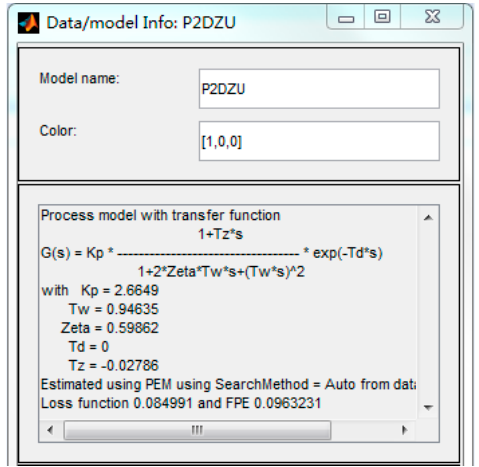
Figure 4. Result of system identification.